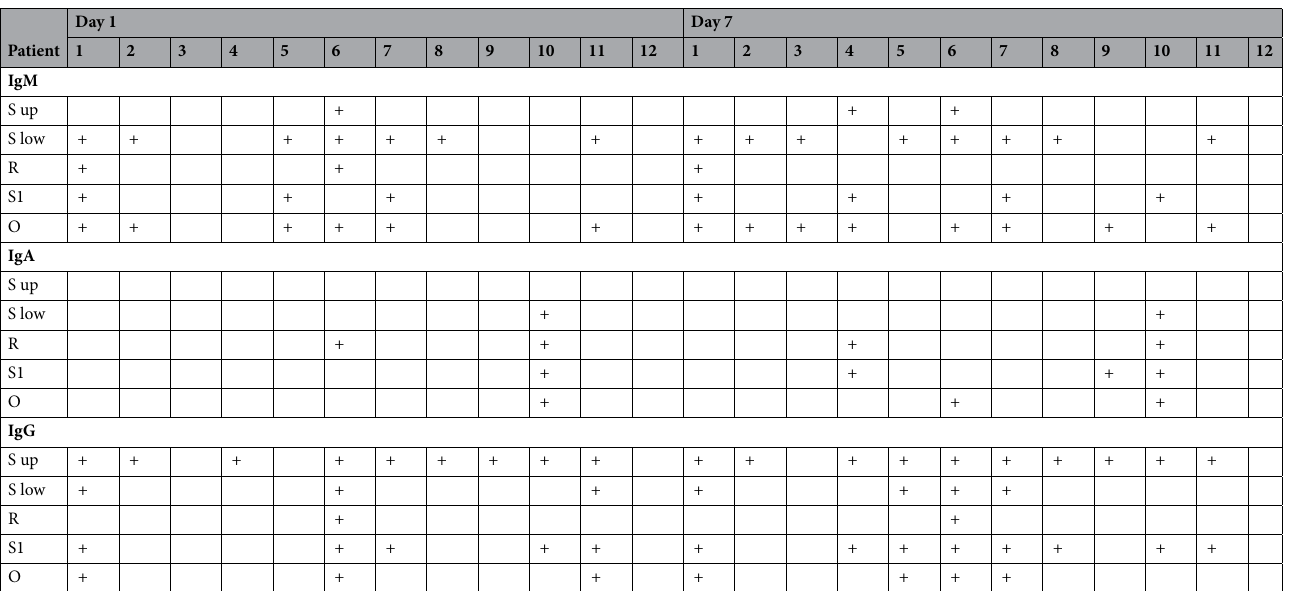
Table 2. Evaluation of the patient immunoblots. The serum of COVID-19 patients 1–12, taken on the day of admission to the hospital (day 1) and again one week later (day 7), was used as a primary antibody to detect the recombinant SARS-CoV-2 proteins S, R, S1, and O by immunoblotting. The presence of anti-SARS- CoV-2 antibodies was determined for IgM, -A, and -G isotype antibodies. A patient was labeled positive for antibodies ( +) if the absolute band intensity of the patient exceeded the highest band intensity of the controls. All immunoblots are depicted in Supplementary Figs.